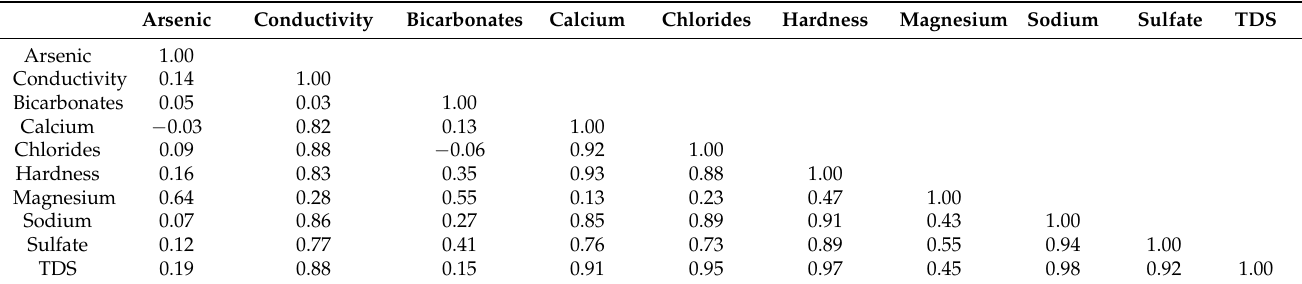
Table 3. Pearson correlations between different